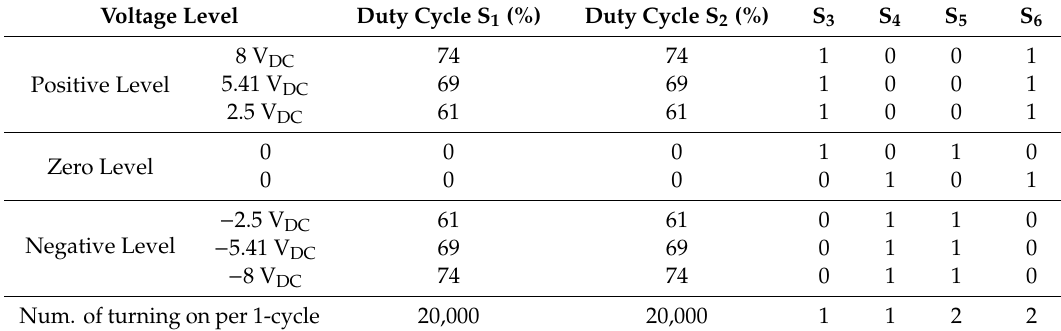
Table 7. Switching table level = 7, gain = 8.